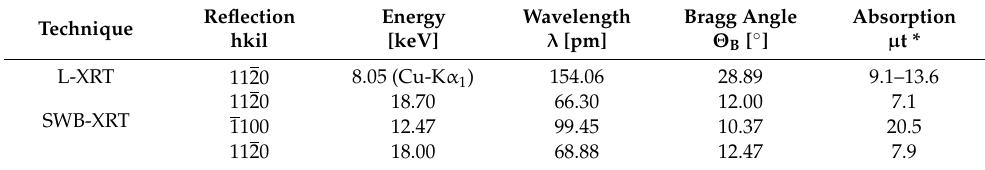
Figure 1. Schematic drawing of Bragg diffraction imaging using ( a ) rocking curve technique with a wide monochromatic incident beam; ( b ) acquisition of an image series (each pixel records its own local rocking curve); and ( c ) reconstructions of maps of the integrated intensity (INT), the full-width at half -maximum (FWHM), and the diffraction peak position (PPOS), extracted on a pixel-by-pixel basis from the local rocking curves. Table 1. Overview of the used measurement conditions for L-XRT, SWB-XRT, and